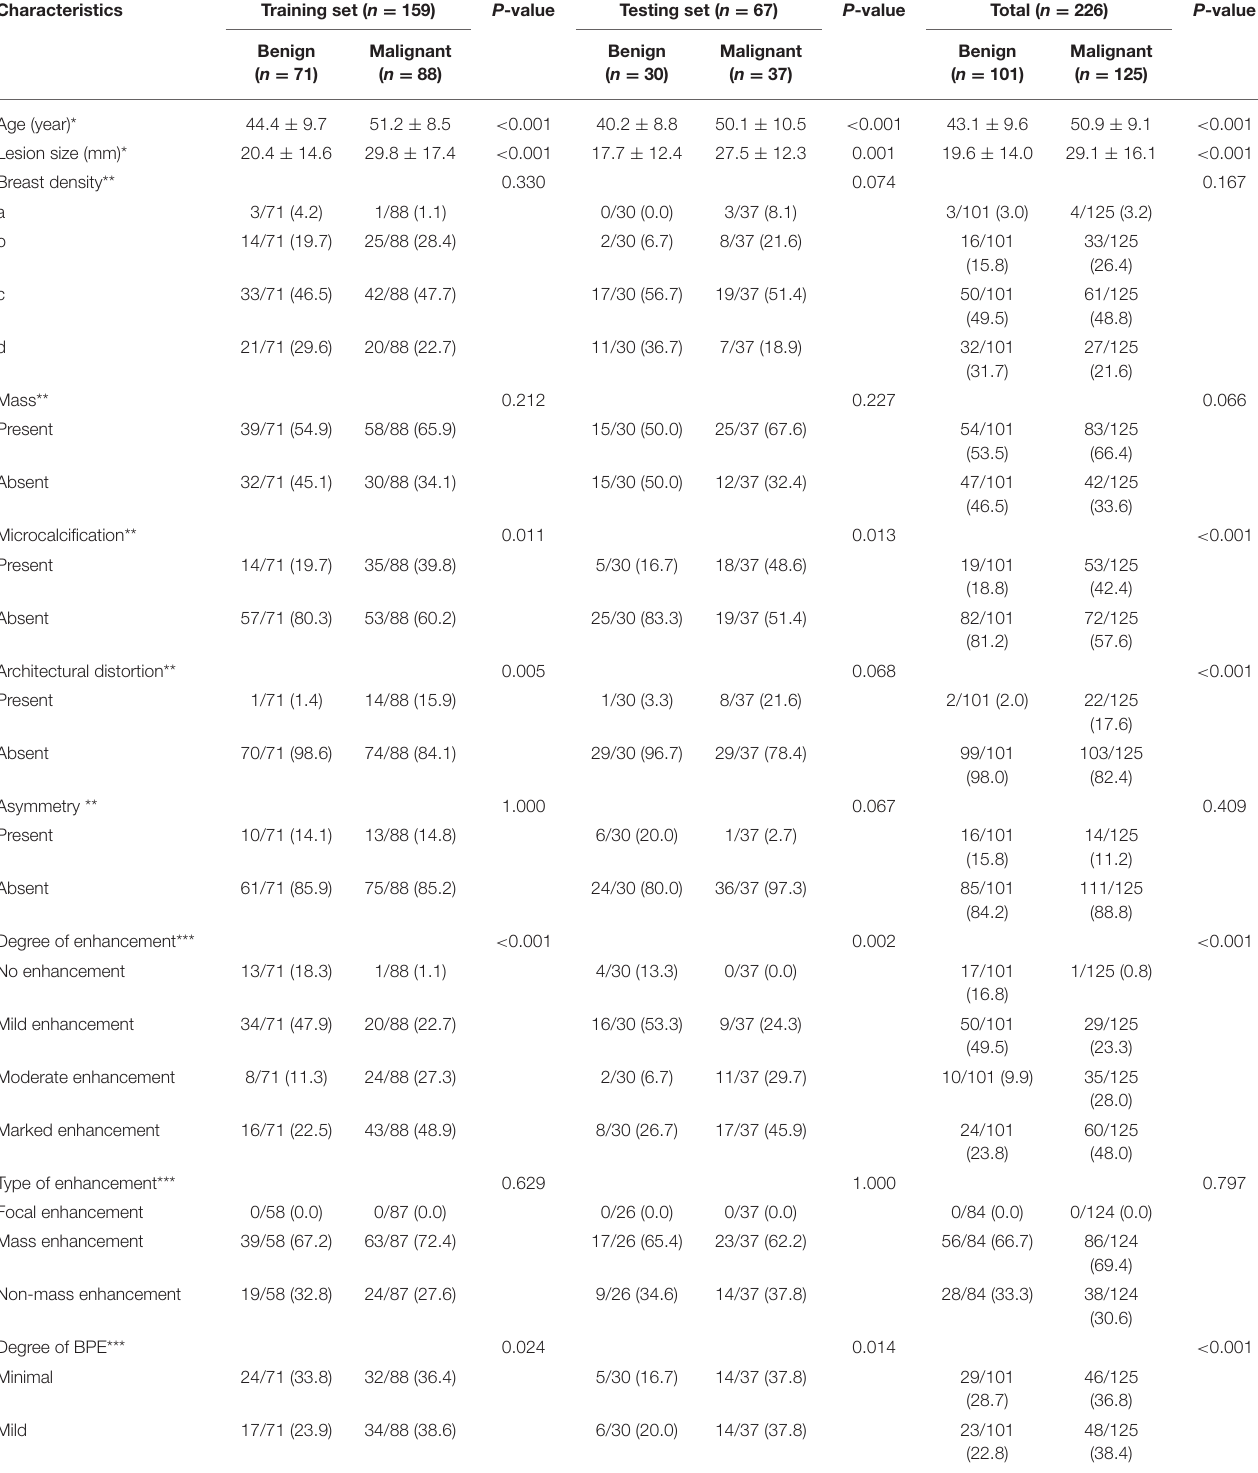
TABLE 1 | Basic patient and lesion characteristics.